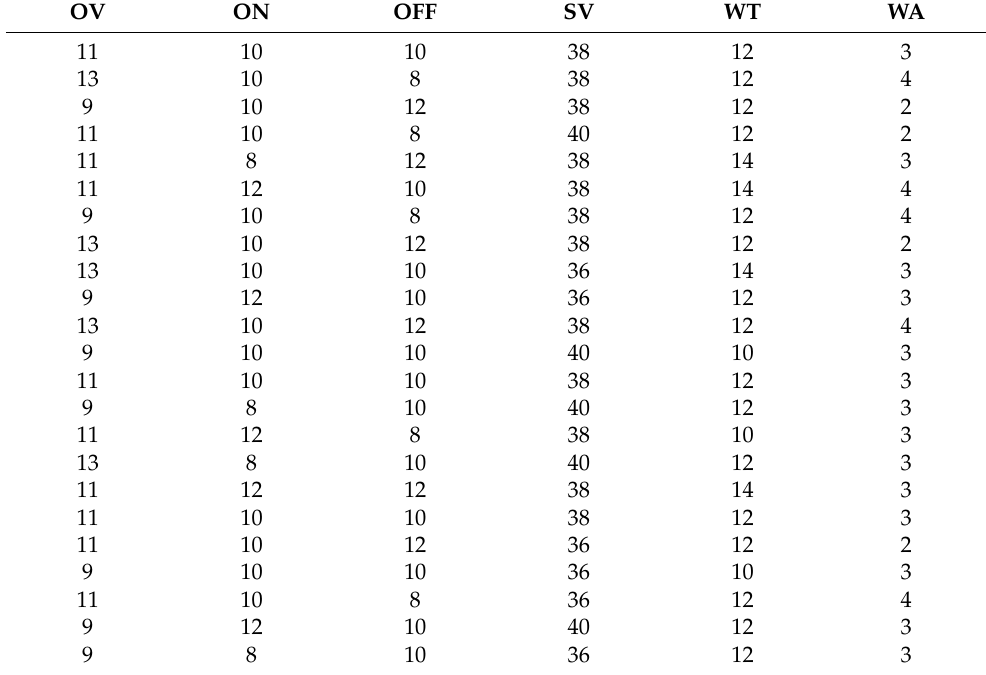
Table 2. Experiment design based on Box–Behnken RSM.